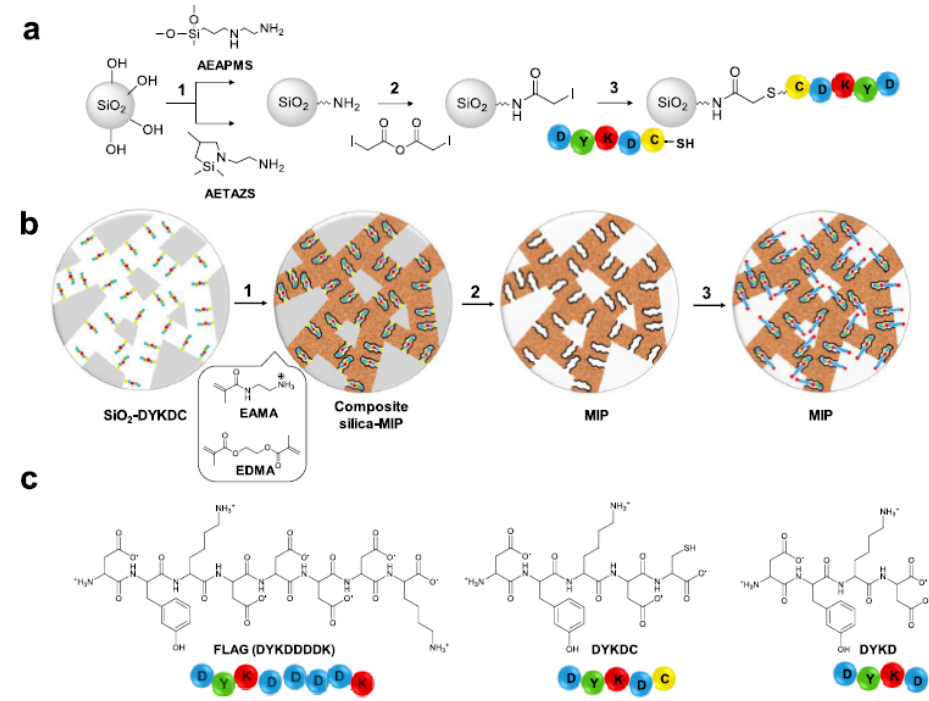
Figure 16. ( a ) Derivatization of silica particles: (1) silanization of rehydroxylated silica beads by using two types of silane agents: AEAPMS (3-(2-aminoethylamino)propyldimethoxymethylsilane) and AETAZS (N-(2-aminoethyl)-2,2,4-trimethyl-1-aza-2-silacyclopentane); (2) iodoacetylation of amino-modified silica particles; (3) peptide DYKDC coupling through the thiol group of the C-terminus cysteine. ( b ) Hierarchically imprinted polymer synthesis: (1) polymerization using EAMA (N-(2-aminoethyl)methacrylamide hydrochloride) as a functional monomer and ethylene glycol dimethacrylate (EGDMA) as a cross-linker; (2) template and silica removal; (3) FLAG recognition by epitope-imprinted cavities. ( c ) Chemical structures of FLAG (DYKDDDDK), DYKDC, and DYKD peptides, where D = aspartic acid, Y = tyrosine, K = lysine, and C = cysteine. Reprinted from [60], with permission from American Chemical Society, 2020.